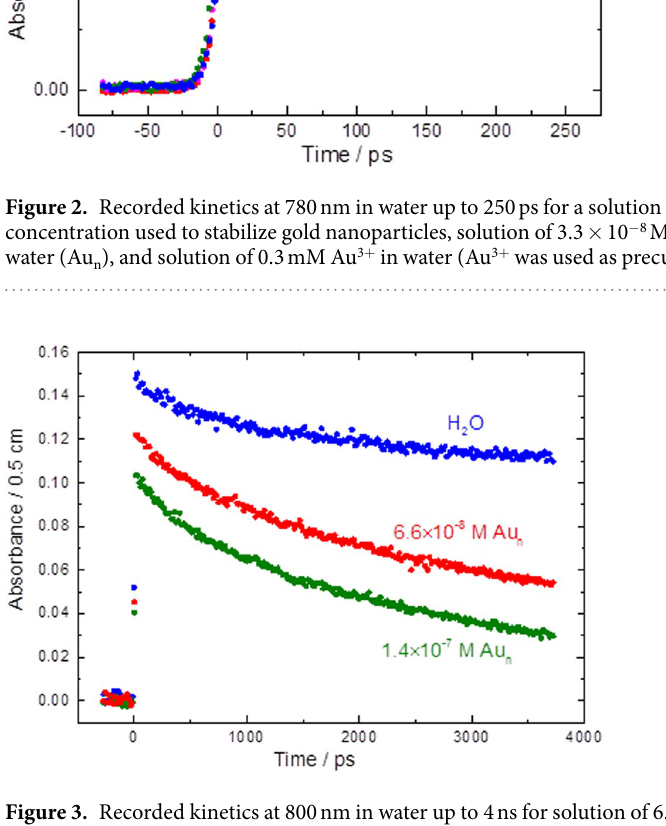
Figure 3. Recorded kinetics at 800 nm in water up to 4 ns for solution of 6.6 × 10 − 8 M (blue circles) and 1.4 × 10 − 7 M naked 15 nm gold nanoparticles in water (Au n ) at 23